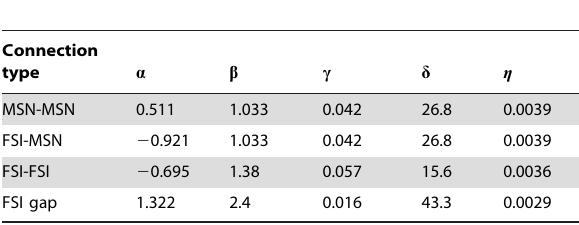
Table 4. Parameters for the expected number of intersections between neuron